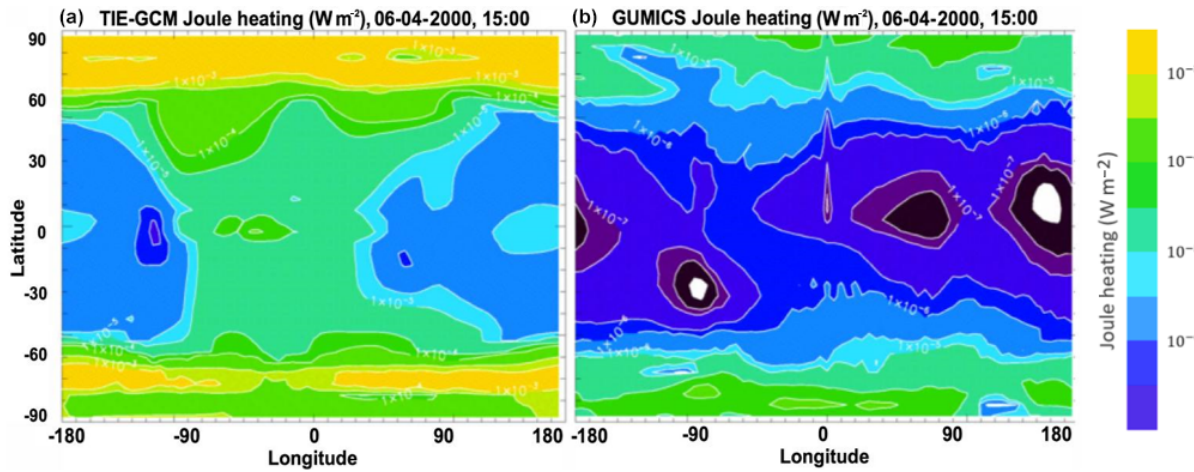
Figure 6. Joule heating from TIE-GCM (a) and GUMICS (b) for the storm of 6 April 2000 (from Sarris et al., 2013). The TIE-GCM results cover latitudes from − 87.5 to 87.5 ◦ . The GUMICS modeling domain covers the high latitudes, at which the code is coupled to the magnetosphere, while at the low and middle latitudes the results represent a continuity over a sphere.